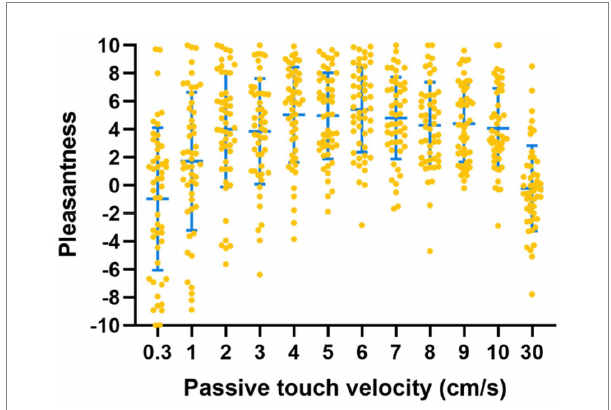
FIGURE 2 Pleasantness ratings for different touch velocities (passive touch). Higher values indicate higher pleasantness. Each orange dot represents the mean ratings of one participant per velocity. The blue bars indicate mean and standard deviation across